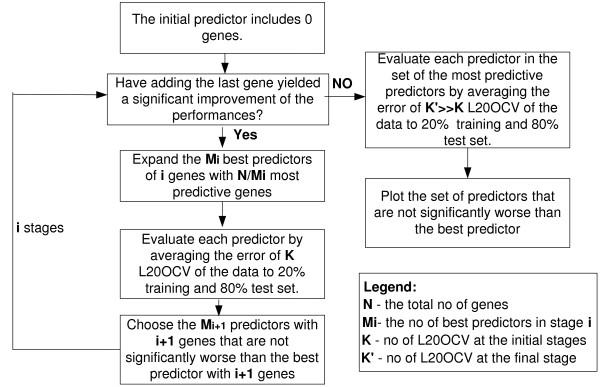
General flow diagram of the procedure for finding the predictors (FLPs or the FTPs, we used k = 100 and k' = 10,000).